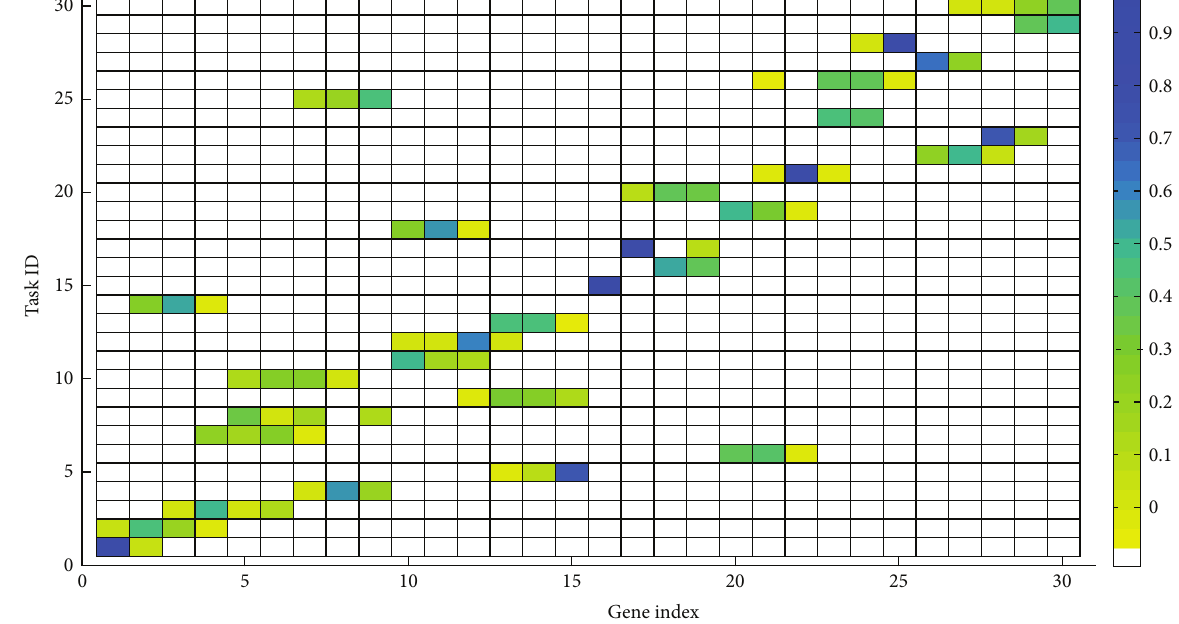
Figure 3: Sample task ID